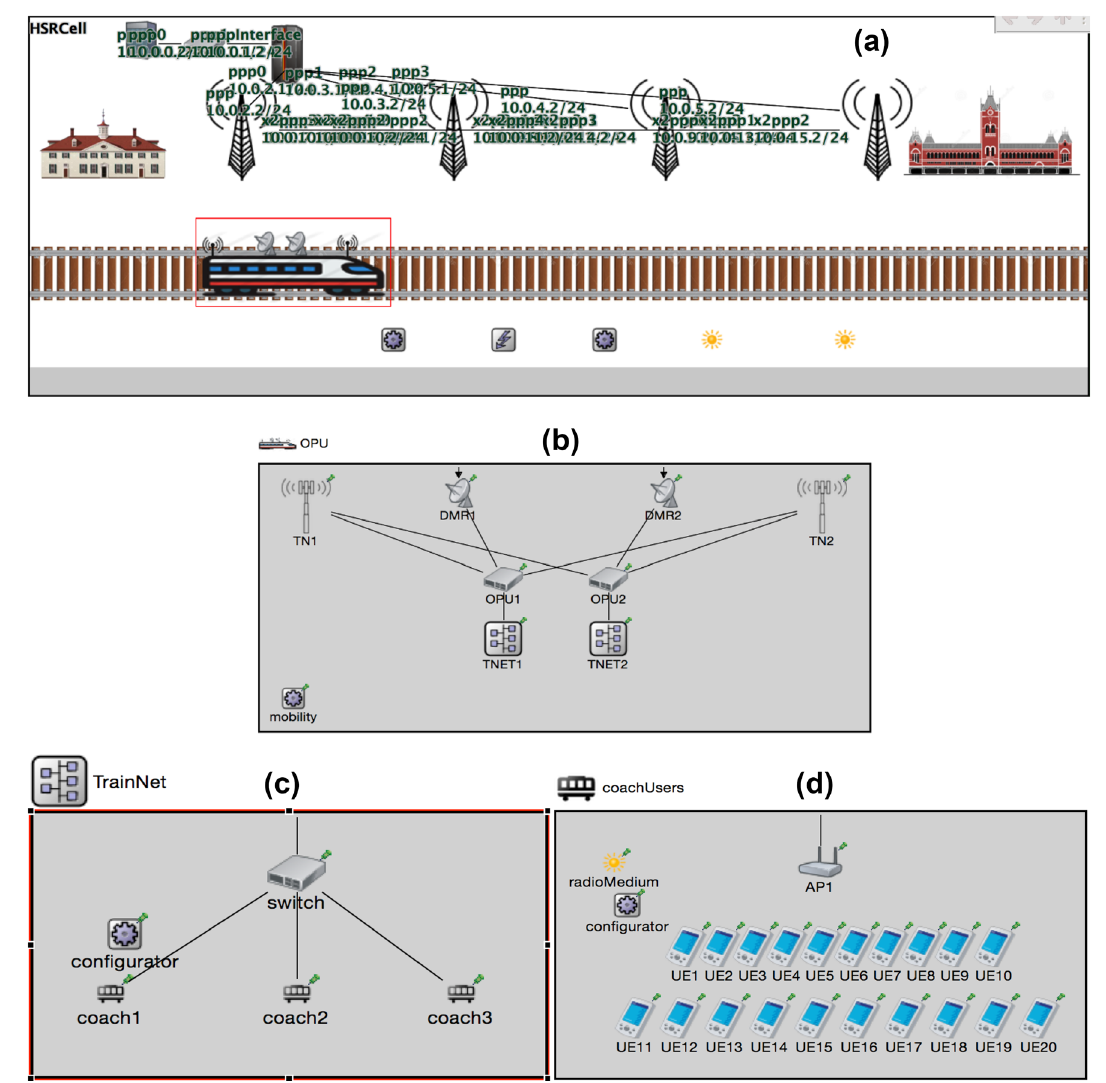
Fig. 6 Omnet ?? simulation screenshot. a HSR simulation between two stations. b Simulated onboard train network. c LAN network across coaches. d Wireless LAN connectivity at